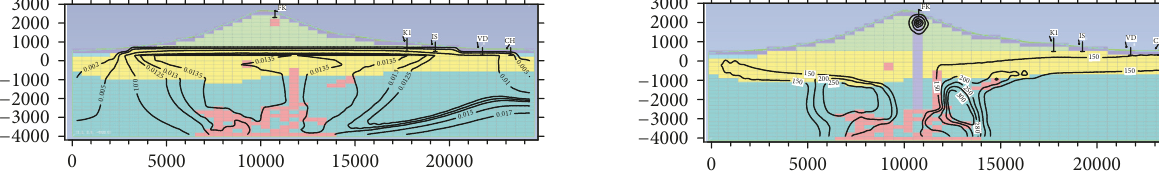
Figure 13: Distributions of modeled temperatures ( ∘ C) (TOUGH2- EOS1) (6A + I). Horizontal and vertical axes are labeled in meters.